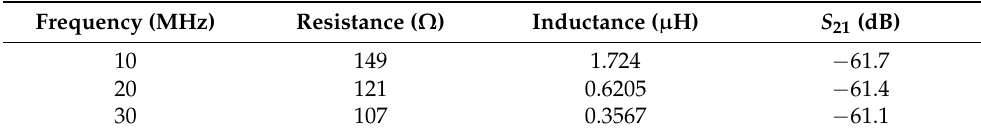
Table 5. Values of the circuit elements for impedance matching and S 21 boosting at each